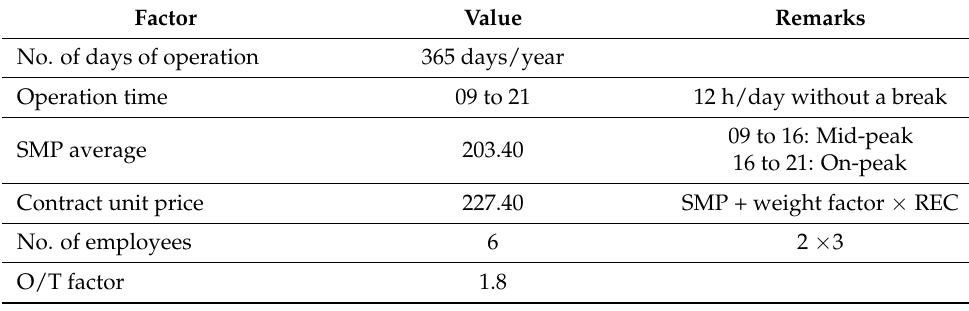
Table 12. Factors and their values are subject to the operation plan (Scenario I).